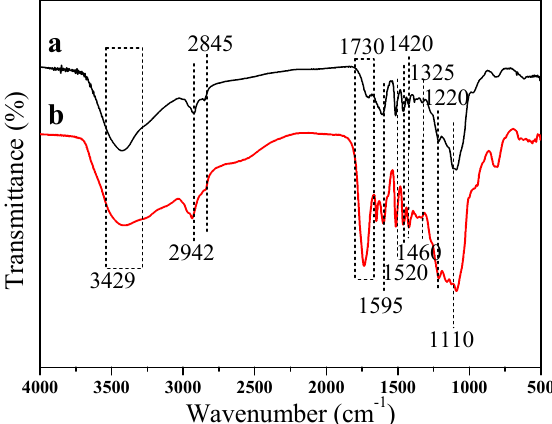
Figure 1. FTIR spectra of lignin (a) and succinic anhydride-based lignin (b).